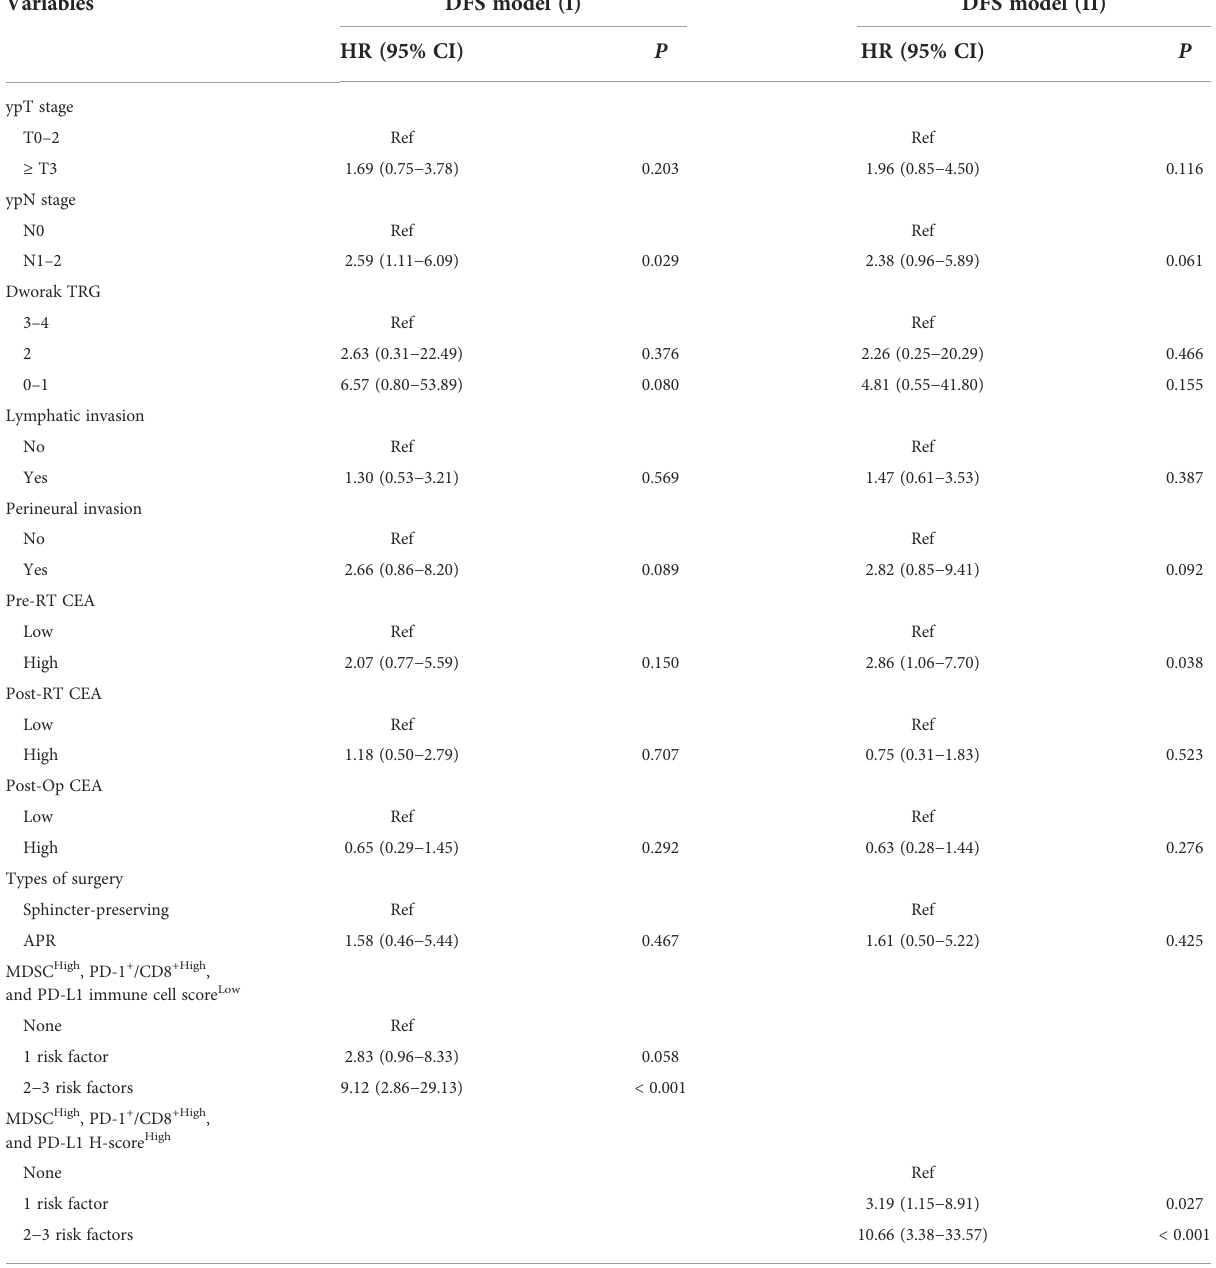
TABLE 1 Cox proportional-hazards regression models for disease-free